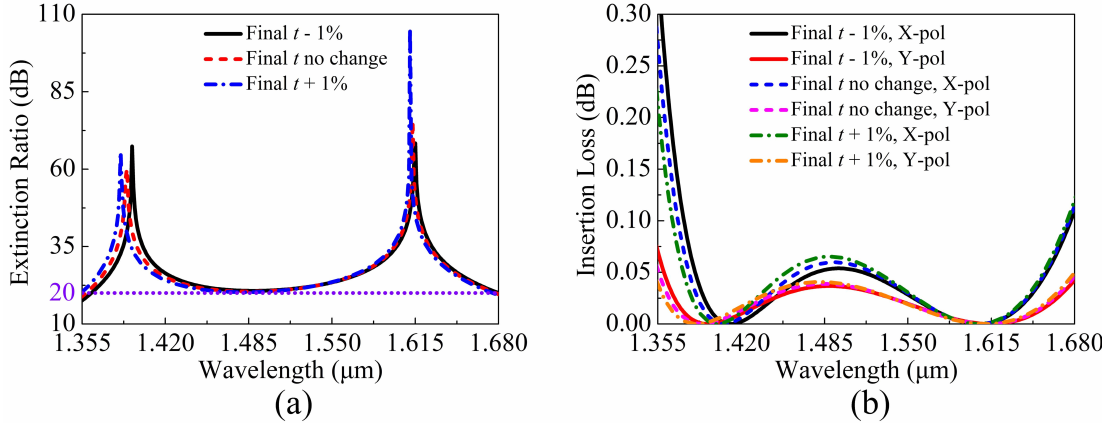
Figure 13. The ILs of the X-pol and Y-pol in the core A of the proposed V-DC-PCF PBS as functions of the wavelength for different SL .